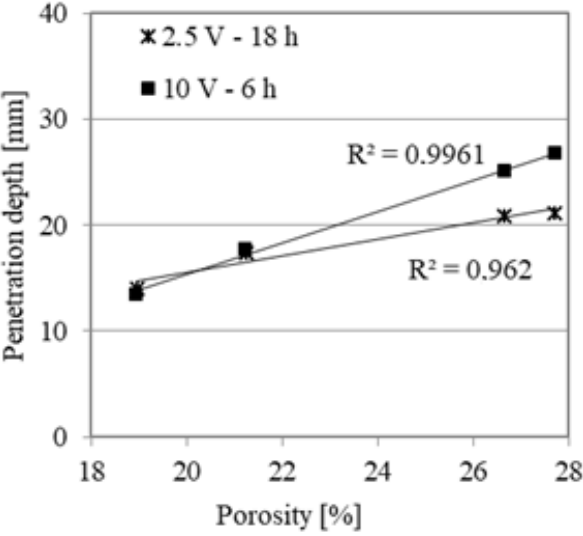
Figure 11. The average chloride penetration depths with reference to porosity.